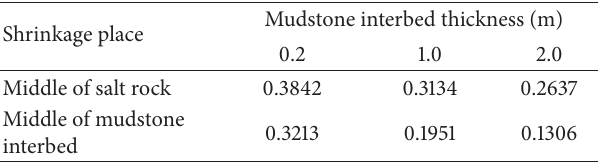
Table 5: The radial displacement of shrinkage per unit time under different mudstone interbed thickness (mm).